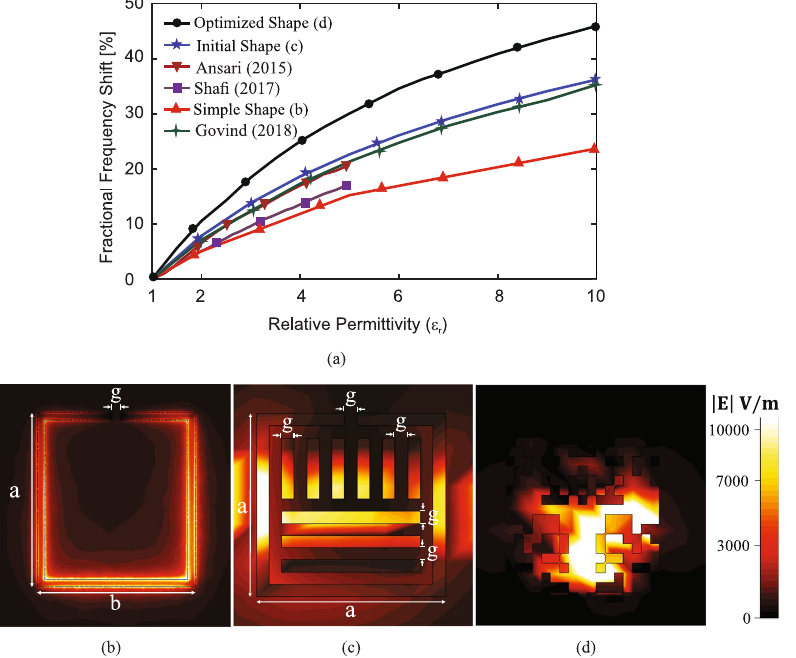
Figure 20. Optimized sensor response with field intensity. ( a ) Comparison between the sensitivity of the proposed shape-optimized sensor with that of the earlier works of Ansari (2015) [89], Shafi (2017) [90], and Govind (2018) [91]. ( b – d ): the electric field intensity distribution on a simple CSRR resonator, the resonator which was considered as the initial state of the optimization and the shape- optimized resonator, respectively. Reprinted with permission from Ref. [37].